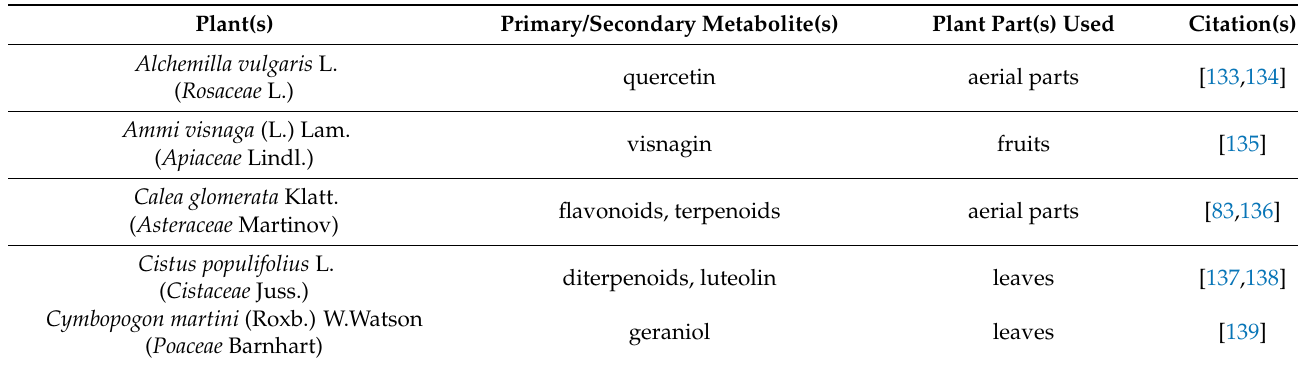
Table 4. Activation of K + channels or inhibition of intracellular Ca 2+